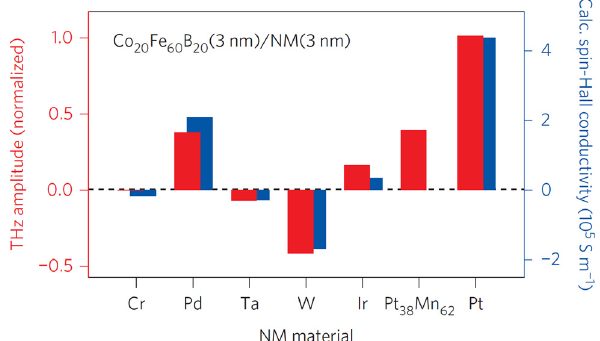
(2) Figure4: SpinHallangleandspinHallconductivityforthenonmagnetic